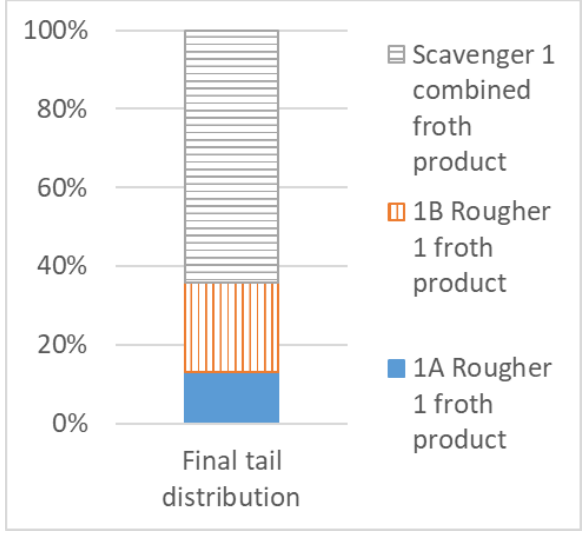
Figure 5. Distribution of hematite in line 1 final tail based on where it originates from. Figure 6 displays the recovery/time plots for the flotation banks.